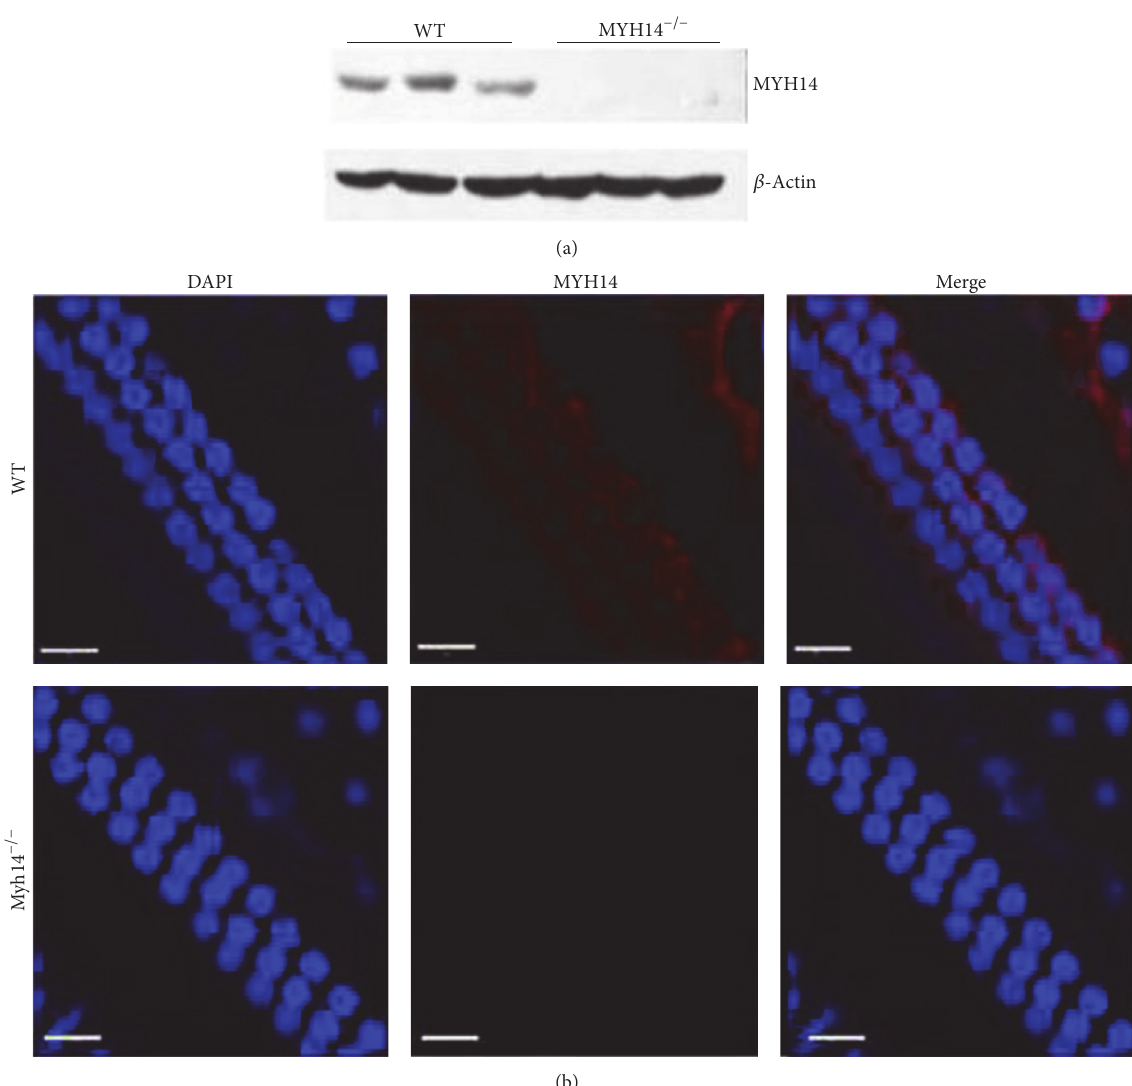
Figure 2: Validation of MYH14 protein knockout in mutant mice. (a) Western blot analysis validation of MYH14 protein knockout in the cerebellums of mutant mice ( 𝑛 = 3 for each group). (b) Confocal images of the basilar membrane in wild type and Myh14 −/− mice. The fluorescence was observed in wild type mice, but no fluorescence was seen in Myh14 −/− mice. Scale bar, 20 𝜇